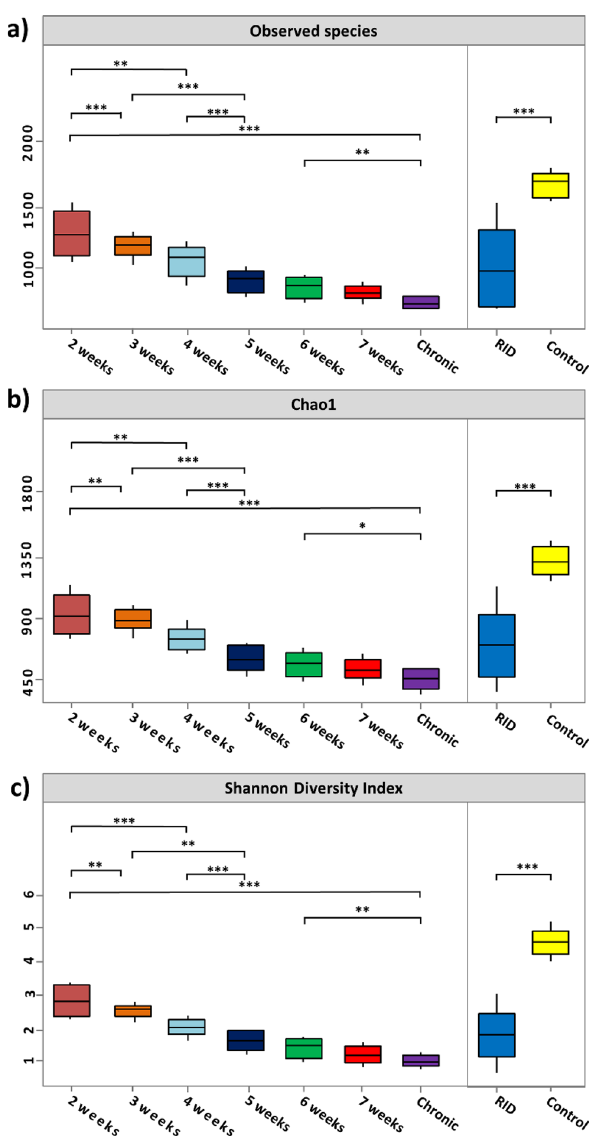
plotted on the X-axis and alpha indices were plotted on the Y-axis. The median is defined by the line in each box, the interquartile range (IQR) between the 25th and 75th percentile were delimited by the box, and the range was represented by the whisker. Statistical significance of pairwise comparisons was defined using the nonparametric Wilcoxon rank-sum test. Only significant differences were displayed with either * (p < 0.05), ** (p < 0.01) or *** (p < 0.001) 36